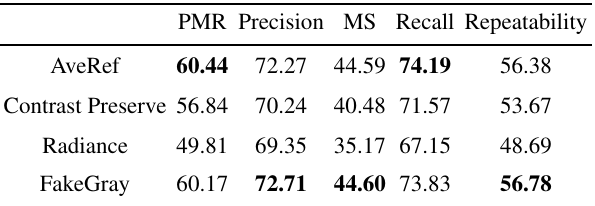
Table 3. Matching Metric for 10-stack points on translation dataset (all data are percentage)